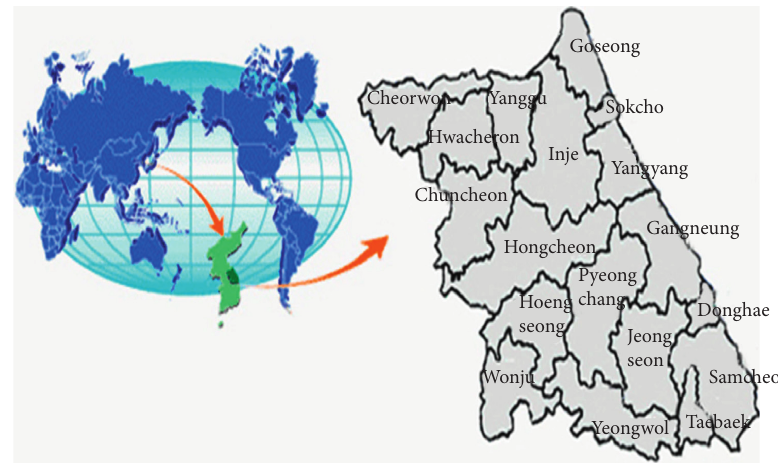
Figure 1: Map of Gangwon Province (accessed at http://www.provin.gangwon.kr/gw/portal).